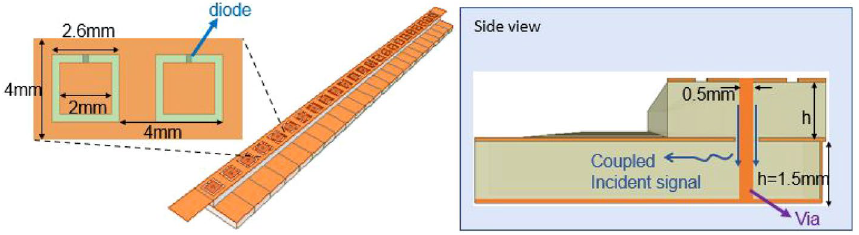
Figure 1. Proposed hybrid RIS hardware design with integrated sensing